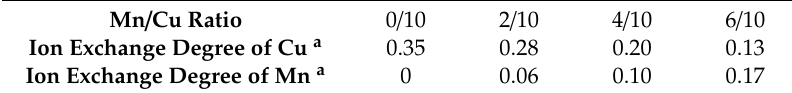
Figure 1. NO conversion of catalysts with di ff erent Mn / Cu ratios under a gas hourly space velocity (GHSV) of 30,000 h − 1 . Table 1. Ion exchange degree of catalysts with di ff erent Mn / Cu molar